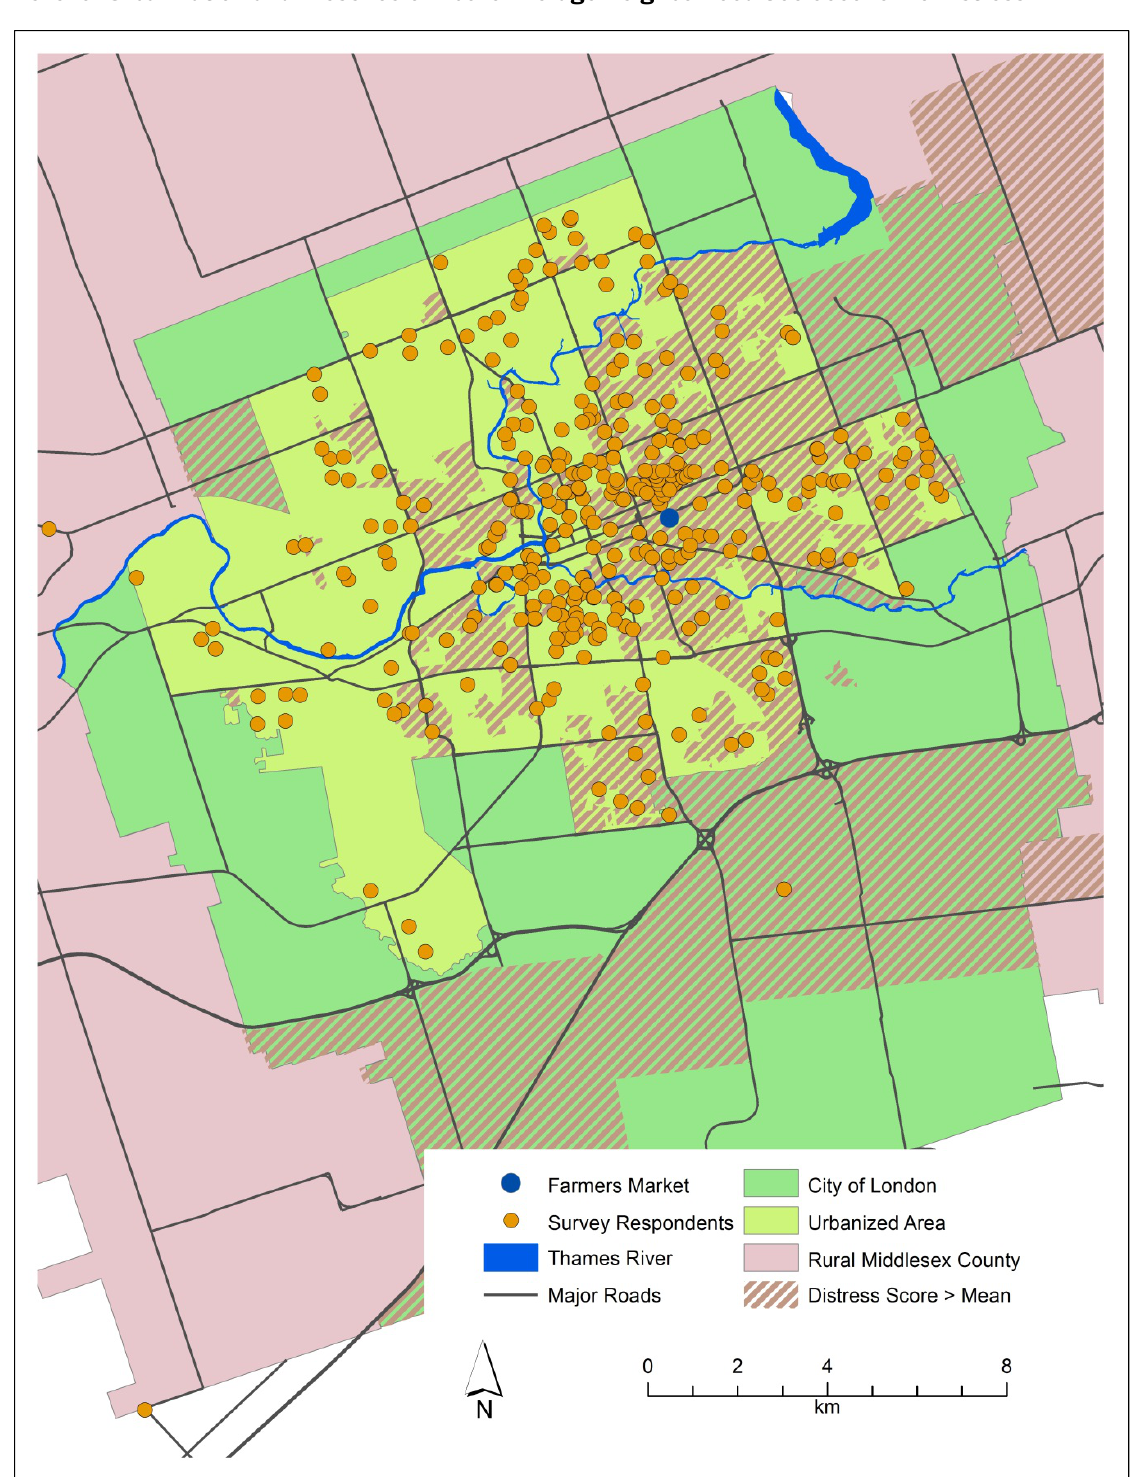
Figure 2. Spatial Distribution of Customers at the Western Fair Farmers’ and Artisans’ Market by Level of Urbanization and Presence of Above-Average Neighborhood Socioeconomic